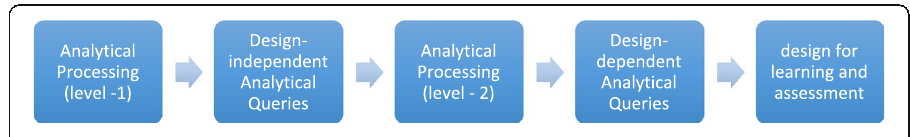
Fig. 1 Analytical processing and query model for embedded